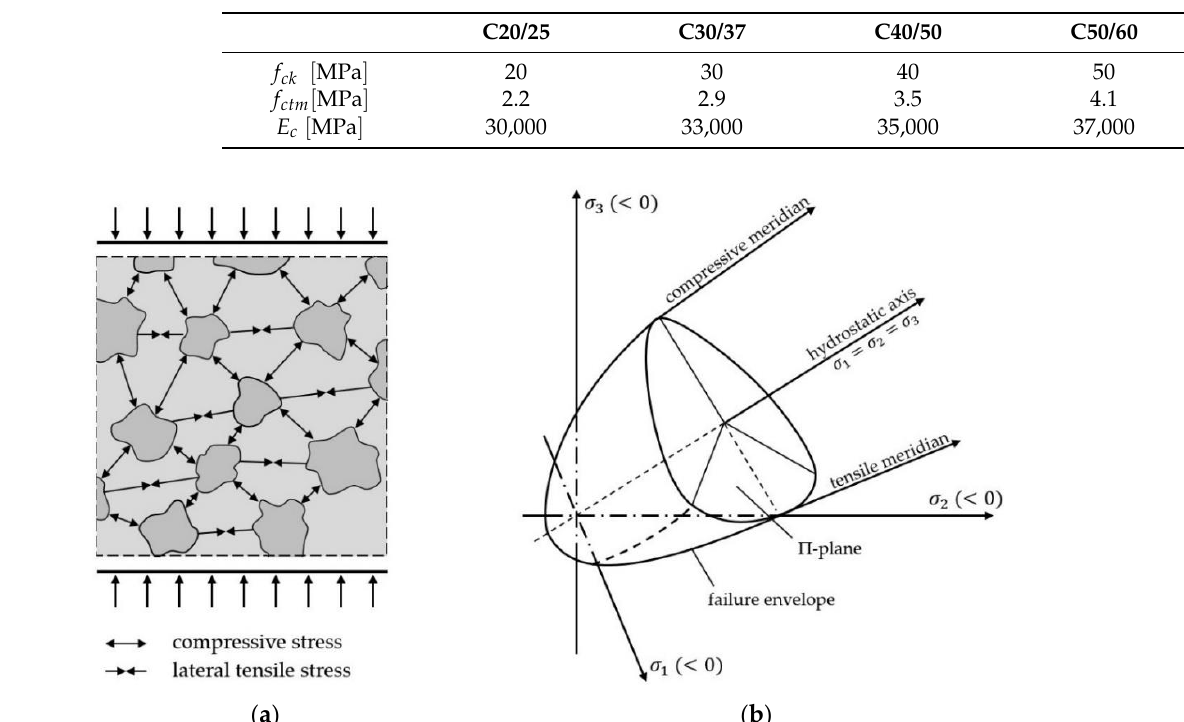
Figure 1. ( a ) Schematic load transfer of an axial compressive load in normal-strength concrete on the meso-level; ( b ) Three-dimensional envelope for different multiaxial loading states. Based on [12]. Table 1. Excerpt of strength-based classifications of concrete according to European codes [24]; char-